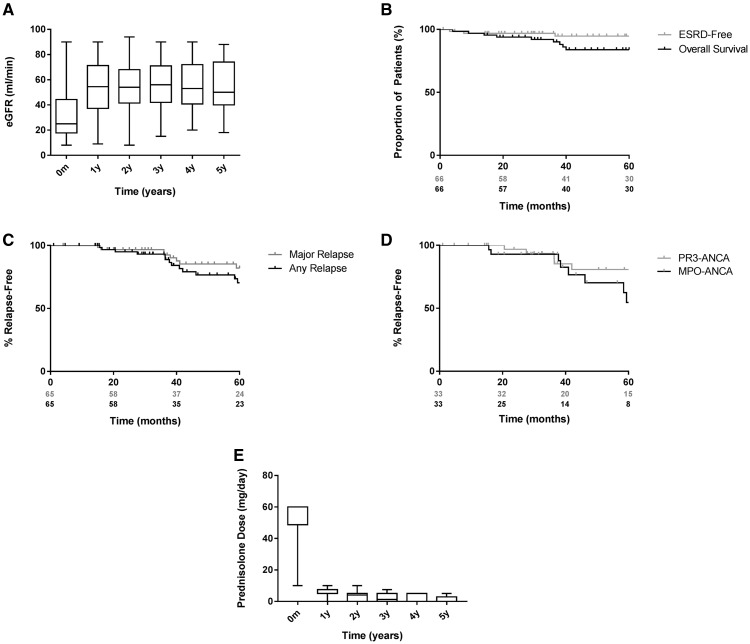
Long-term outcomes during 5-year follow-up. (A) eGRF (mL/min) at annual intervals during 5-year follow-up. Data censored at point of progression to end-stage renal disease for four patients. Unadjusted Kaplan–Meier survival functions describing (B) overall and ESRD-free survival (the latter censored for death) and relapse-free survival censored for death in (C) MPO-ANCA- and (D) PR3-ANCA-positive patients during the 5-year follow-up. (E) Long-term steroid exposure in the cohort during the 5-year follow-up (censored for relapse). Box and whisker plots represent median (IQR) and range measurements.